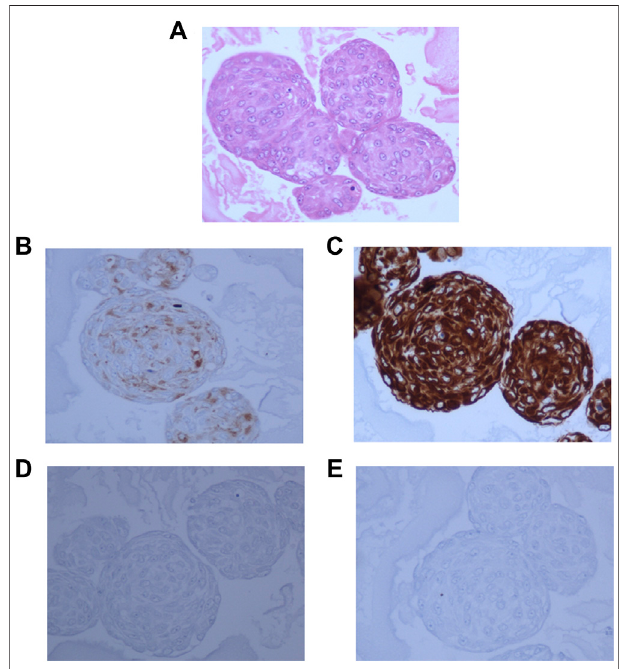
FIGURE 4 | 3D neurospheres sections embedded in ovalbumin and processed for FFPE blocks. (A) : Hematoxylin and Eosin staining showing denselypackedcellsthroughouttheneurosphere. (B) :Densepositivestaining for Synaptophysin. (C) : Very strong positivity for Vimentin, (D) : negative staining for GFAP, and (E) : Very low positive staining for MIB-1 stain.